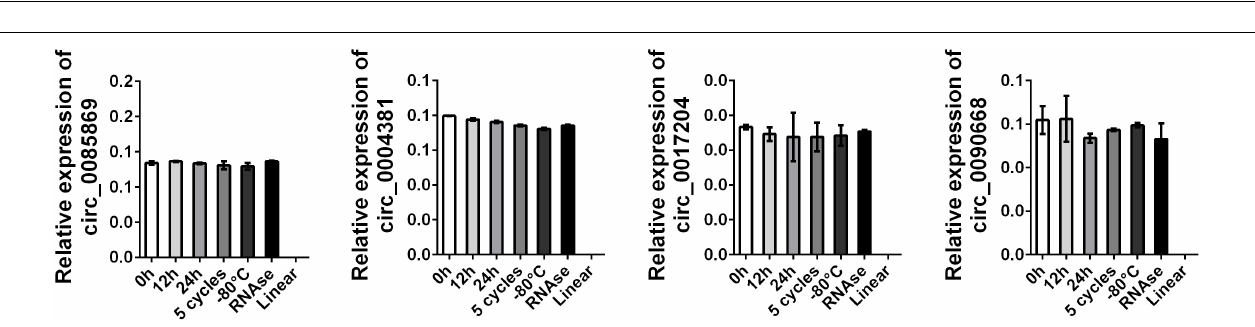
FIGURE 7 | Stability detection of circRNA panel in human plasma. RT-qPCR was applied for detecting the expression level of the four circRNAs. Data was presented as mean ± SEM with log-transformed. No significant difference was observed in each group.